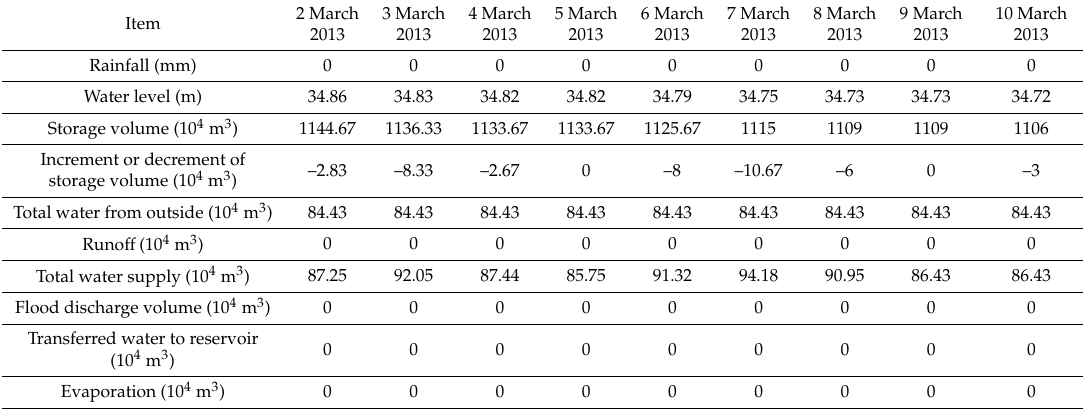
Table 6. The results of the Shiyan reservoir during the operation process.